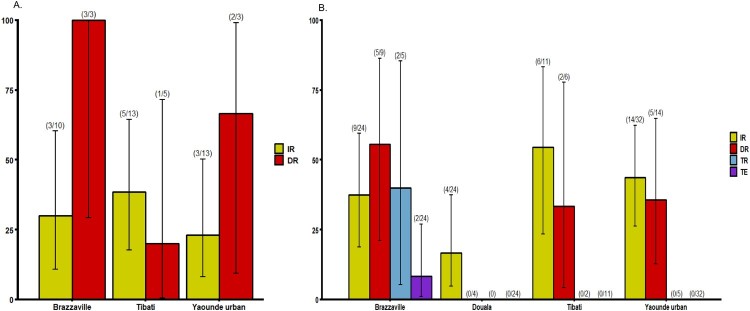
Infection, disseminated infection, transmission rates and transmission efficiency of Ae. albopictus from Central Africa to yellow fever virus. (A) Infection and disseminated infection rates at 14 days post-infection (dpi). (B) Infection, disseminated infection, transmission rates and transmission efficiency at 21 dpi. Error bars show the 95% confidence interval. In brackets, the number of mosquitoes examined. IR: the proportion of mosquitoes with infected body among engorged mosquitoes; DIR: the proportion of mosquitoes with infected head among mosquitoes with infected body; TR: the proportion of mosquitoes with infectious saliva among mosquitoes with infected head. TE: the proportion of mosquitoes with infectious saliva among all analysed ones.